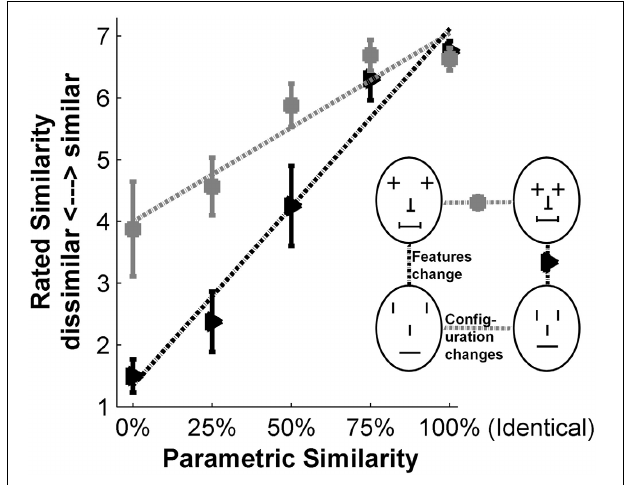
FIGURE 6 | Exemplar results of one German participant of the similarity ratings. For each of the five similarity levels, the average ratings across all face comparisons of all sets were calculated. The sensitivity ratings for changes in features (black triangles) and configuration (gray squares) are shown separately. The error bars depict standard error. A linear regression ( y = β x + ε ) was fitted to both curves individually (dotted black and dotted gray, respectively). The slopes ( β ) serve as measure of the sensitivity to features and